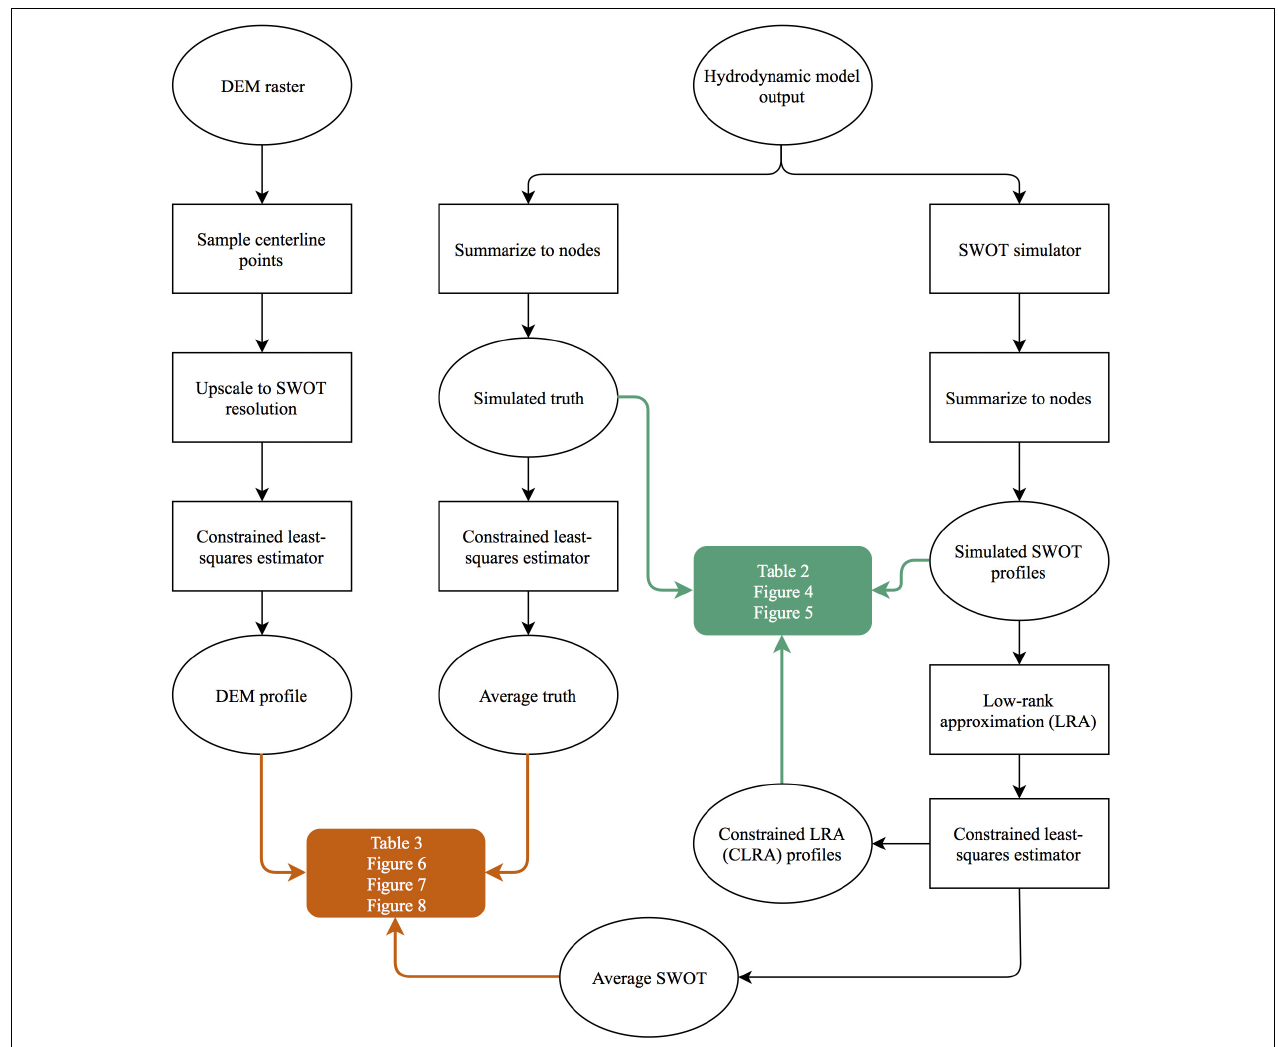
FIGURE 3 | Flow chart of processing and smoothing methods of elevation data. Ovals represent data and rectangles represent